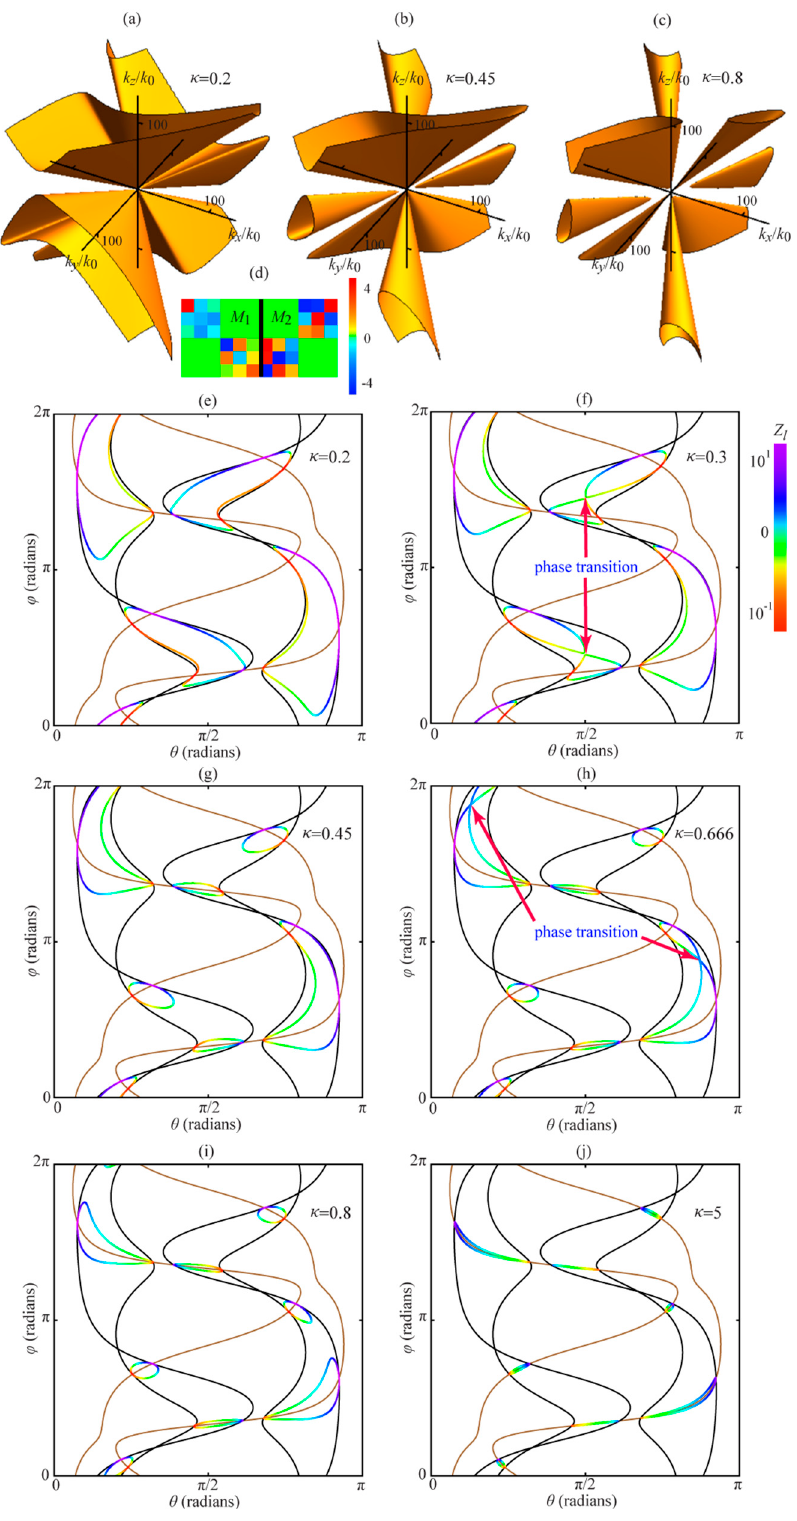
Figure 3. Topological phase transitions ( f , h ) between bihyperbolic ( a , e ), trihyperbolic, ( b , g ) and tetrahyperbolic ( c , i ) phases with material parameters matrix ˆ M = ˆ M 1 + i κ ˆ M 2 as κ is changed. Matrices 𝑀 (cid:2869) , 𝑀 (cid:2870) are plotted in ( d ). Panel ( j ) shows the limit of high κ . The HKP states for the 𝜅 noted in panels (e)–(j) are color-coded in accordance with their 𝑍 (cid:3039) as indicated to the right of Figure 3f. The HKP for nonzero 𝜅 are positioned in the (cid:4666)𝒌 (cid:3021) 𝜖̂𝒌(cid:4667)(cid:4666)𝒌 (cid:3021) 𝜇̂𝒌(cid:4667) (cid:3408) 0 regions between the 𝜅 (cid:3404) 0 lines, in accordance with Equations (14) and (18), and touch these lines at the intersections of 𝜅 (cid:3404) 0 and (cid:3435)𝒌 (cid:3021) 𝑋(cid:3552)𝒌(cid:3439) (cid:3404) 0 . The HKP states group into several disconnected curves,